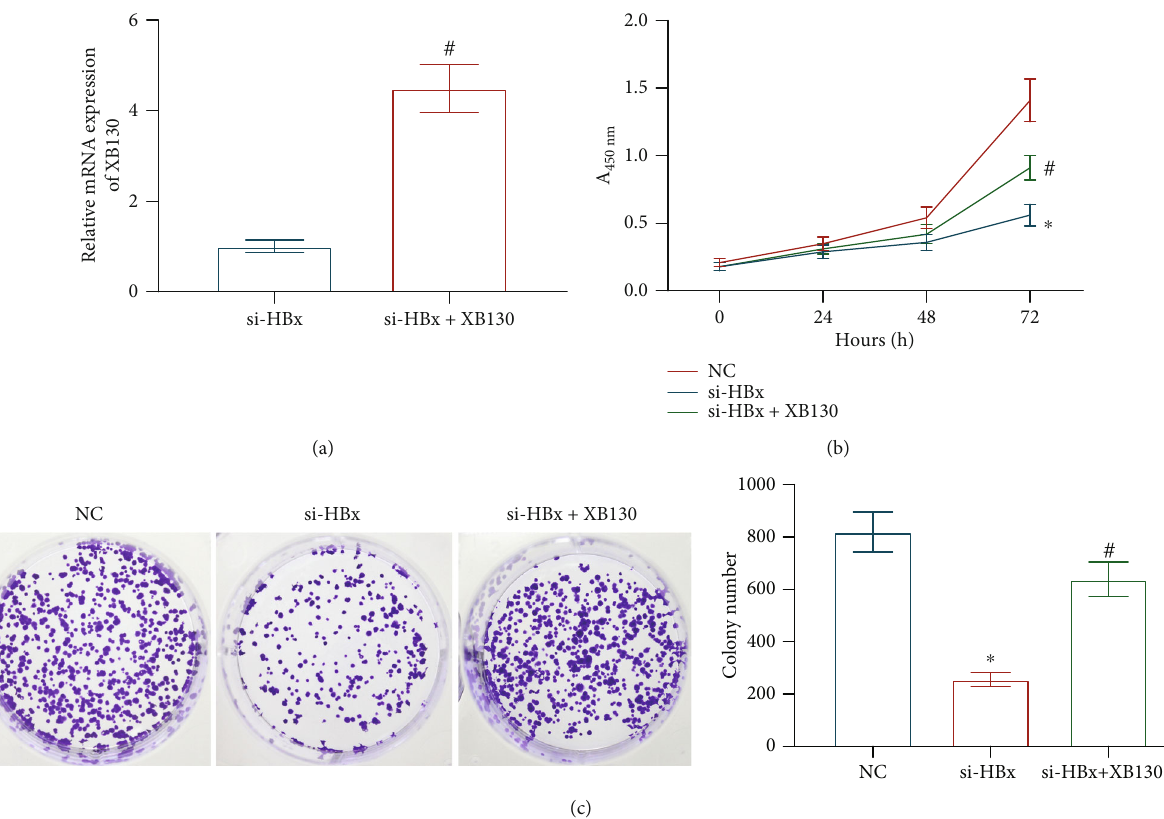
Figure 4: HBx/XB130 axis facilitates proliferation of HepG2 cells. (a) Transfection e ffi ciency of cells with silenced HBx and overexpressed XB130 detected by RT-qPCR. (b) Proliferative ability of cells examined by CCK-8 assay. (c) Colony formation ability of cells examined by colony formation assay. ∗ # p < 0 : 05